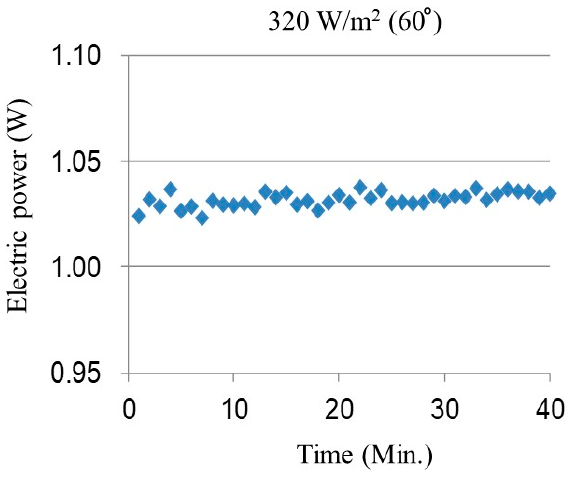
Figure 16. Electric power generated by large-scale OPV-solar chimney as a function of time.